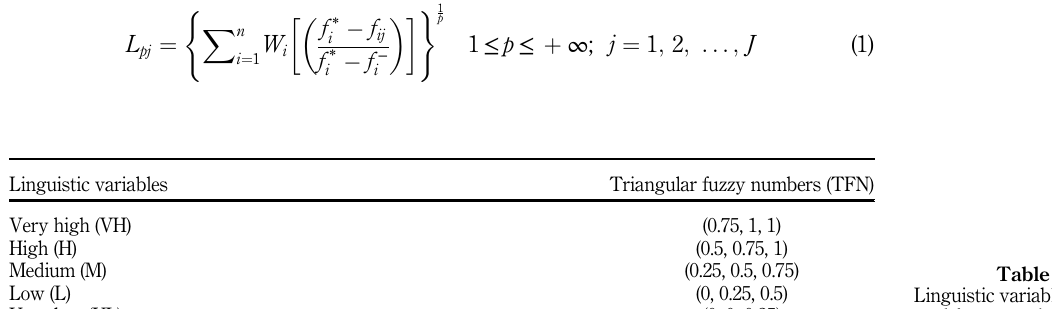
Table 2. Linguistic